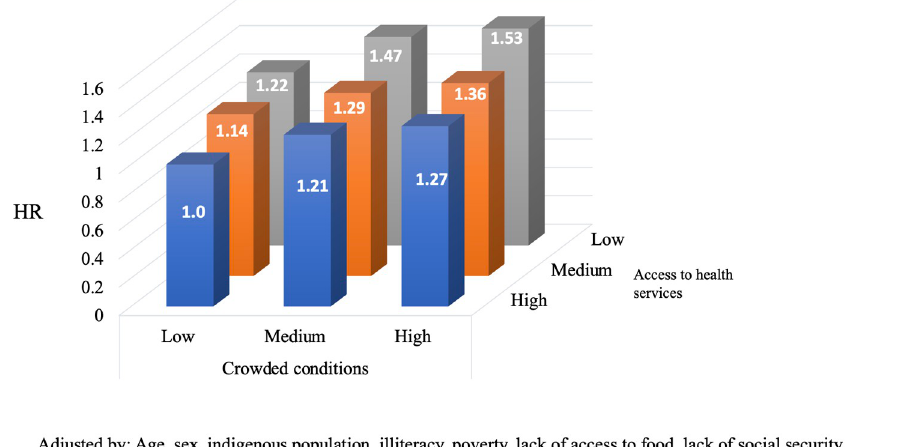
Fig 1. Interaction between crowding conditions and access to health services and mortality on patients with COVID-19.